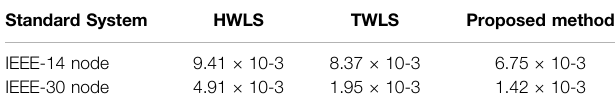
TABLE 4 | Average absolute error of voltage amplitude under non-Gaussian noise (pu).